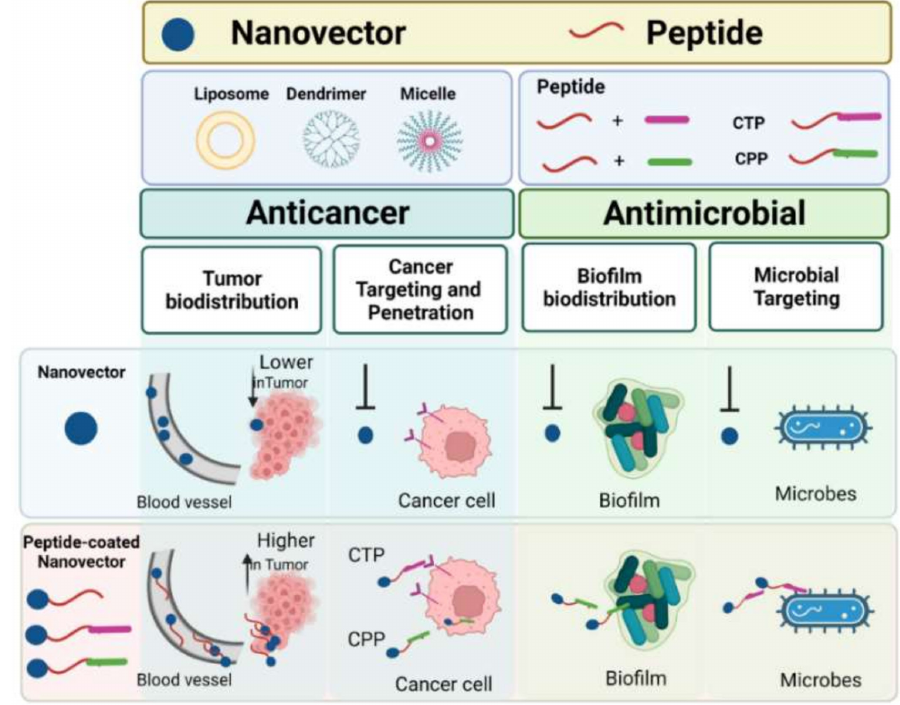
Figure 1. The main advantages in drug delivery by peptide-coated NVs with cell-targeting peptides (CTP) or cell-penetrating peptides (CPP) in comparison to NVs alone are reported with particular attention to their anticancer (on the left ) and antimicrobial (on the right ) applications. This figure was created with BioRender.com (accessed on 2 February